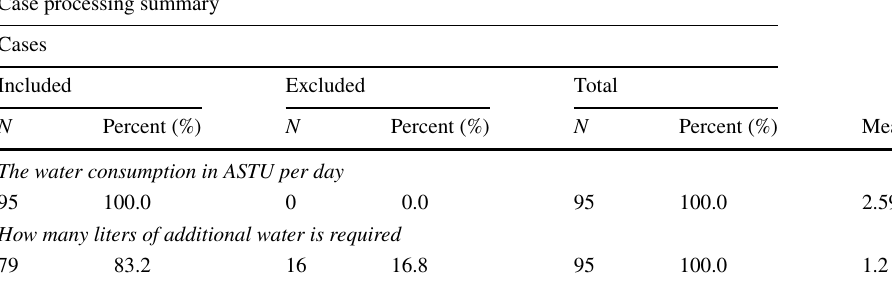
Table 6 Daily mean per capita consumption based on the respondents’ water